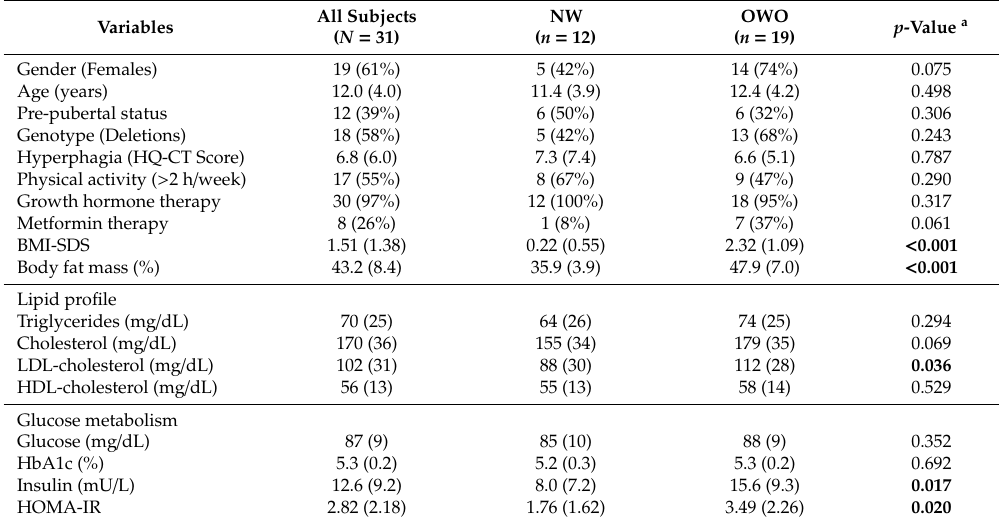
Table 1. Demographic and metabolic characteristics of